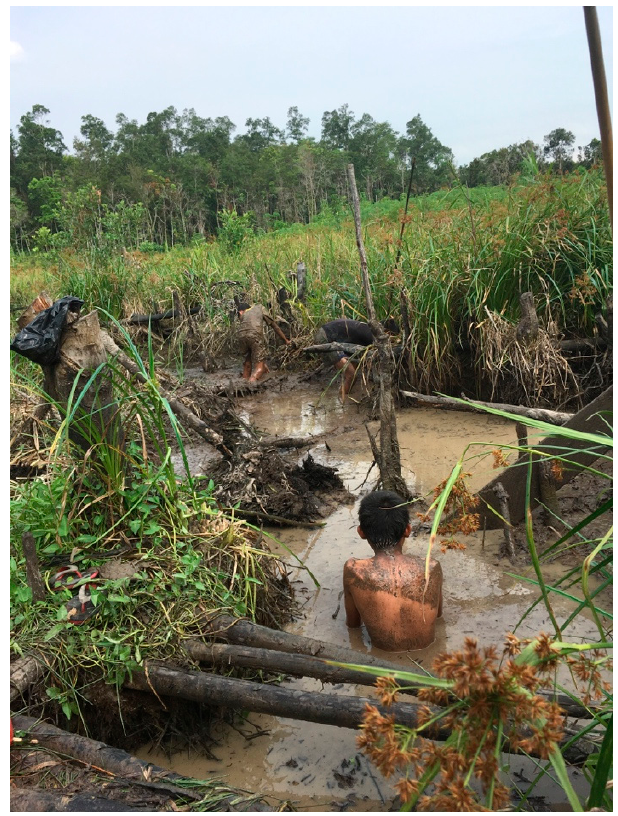
Figure 2. Children clearing root vegetables from newly cleared peatland drainage ditch. The area is